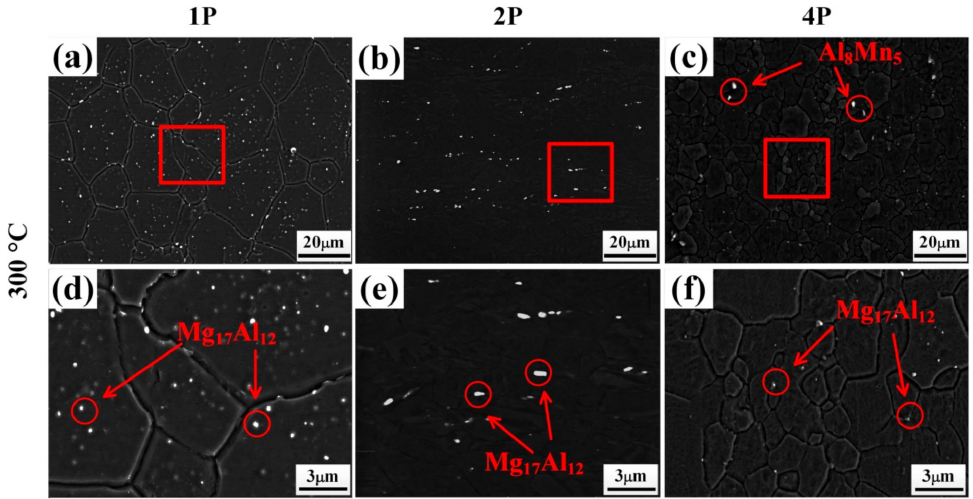
Figure 6. SEM images of ECAP samples at 300 ◦ C: ( a , d ) 1 pass, ( b , e ) 2 passes, and ( c , f ) 4 passes. ( d – f ) are the high-magnification images of ( a – c ),